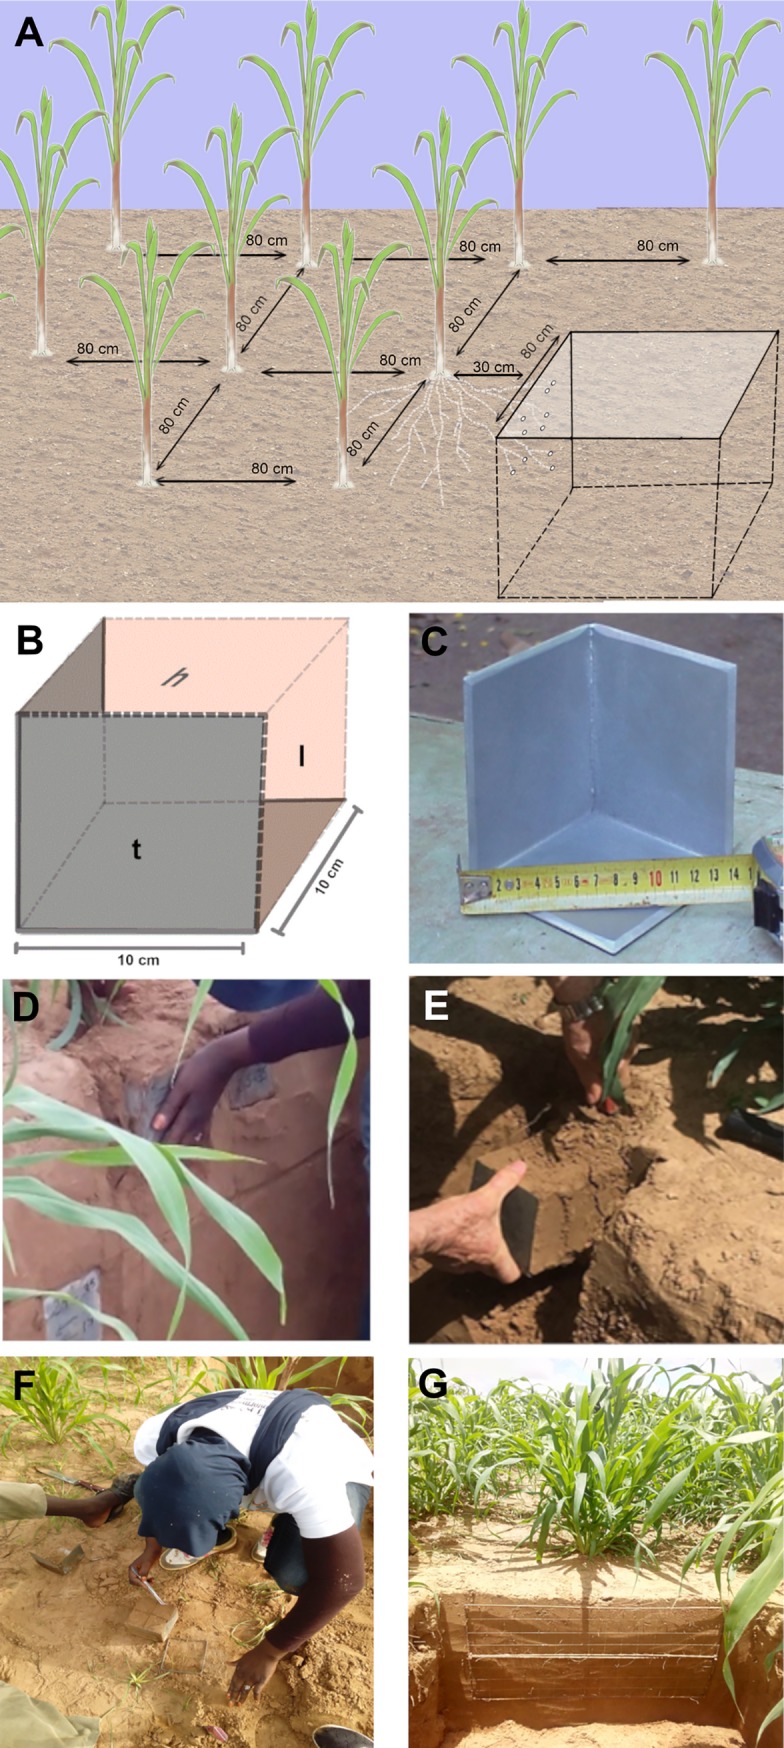
Root intersections density (RID) counting method used for root length density (RLD) modeling from RID.(A) Experimental design and trench profile for root sampling (at 30 cm from the plant in this example), (B) and (C) sampling device with sides oriented according to the soil surface and plant row (H: horizontal, L: longitudinal, T: transversal), (D) and (E) root sampling process, (F) Root impacts counting on all three sides of soil cubes extracted from the trench profile, and (G) grid (5x 5 cm mesh) on a soil profile for soil-roots intersections counting (RI).